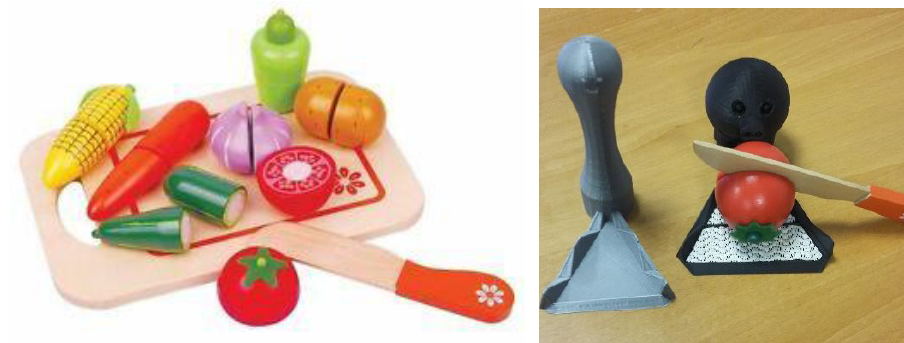
Fig. 1. Example of a toy adaptation: vegetable holding tool to facilitate cutting. On the left picture, the original toy is displayed. On the right picture, we see the modification proposed, in the form of a handle and a positioning pad that hold the fruit to cut. The left object in the right picture is the result of the first iteration; after the formative evaluation, the student embarked into a second design iteration, which lead to the object on the